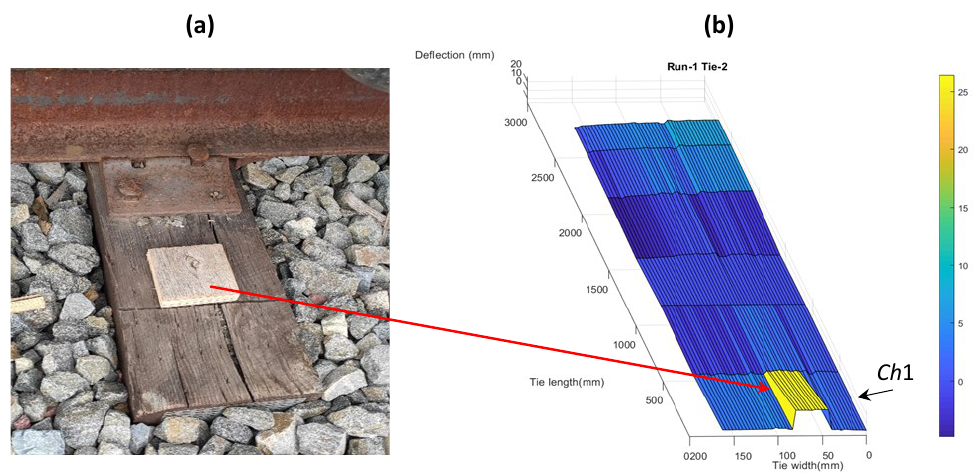
Figure 18. ( a ) Wood block placed on one of the ties and ( b ) 3D tie deflection profile with the wood block near transducer 1 ( Ch 1).